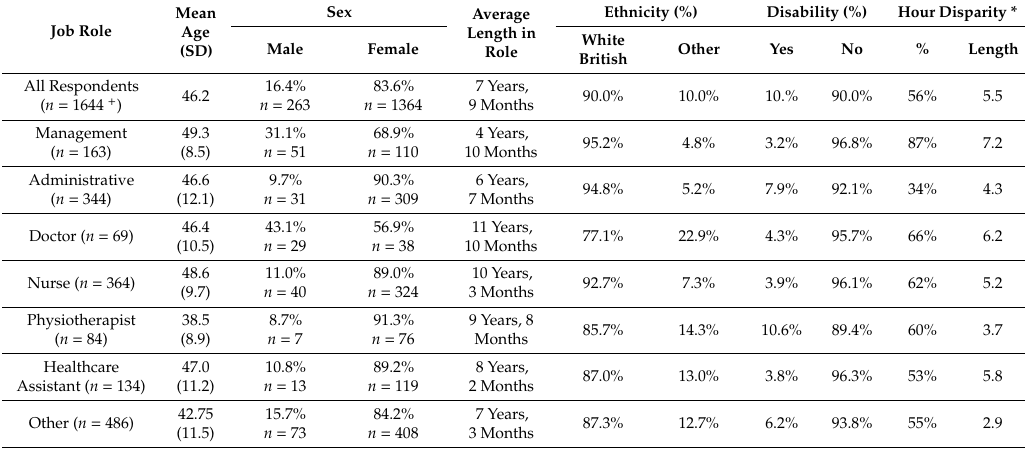
Table 1. Demographic scoring and hour disparity for all respondents, broken down by job